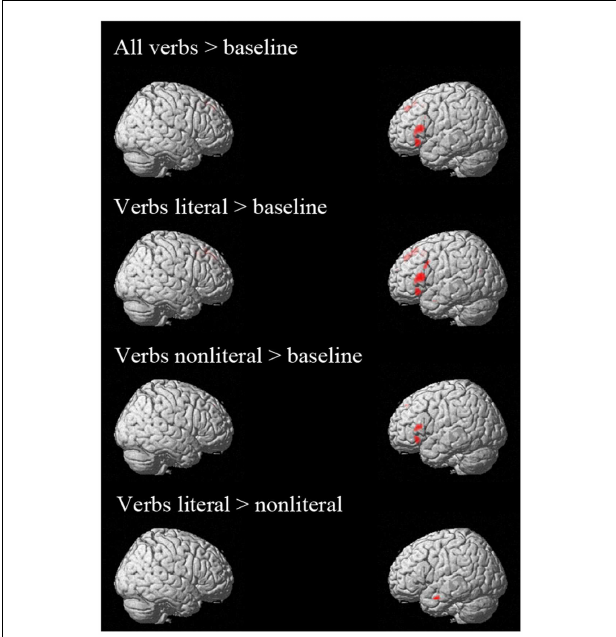
FIGUREA1 |Activation additional whole brain analyses. All contrasts are thresholded at p < 0.05 FWE